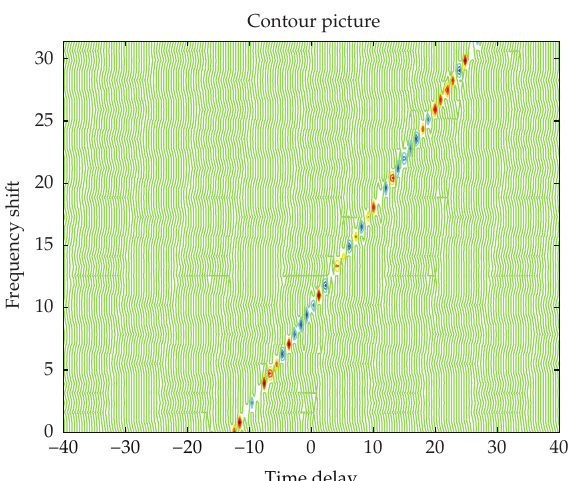
Figure 3: The contour picture of WDL of f (cid:4) t (cid:5) .